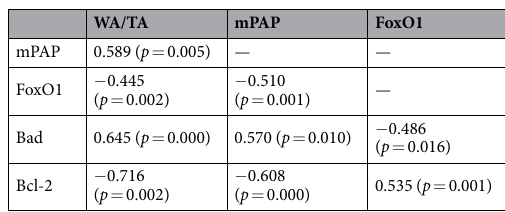
WA/TA mPAP FoxO1